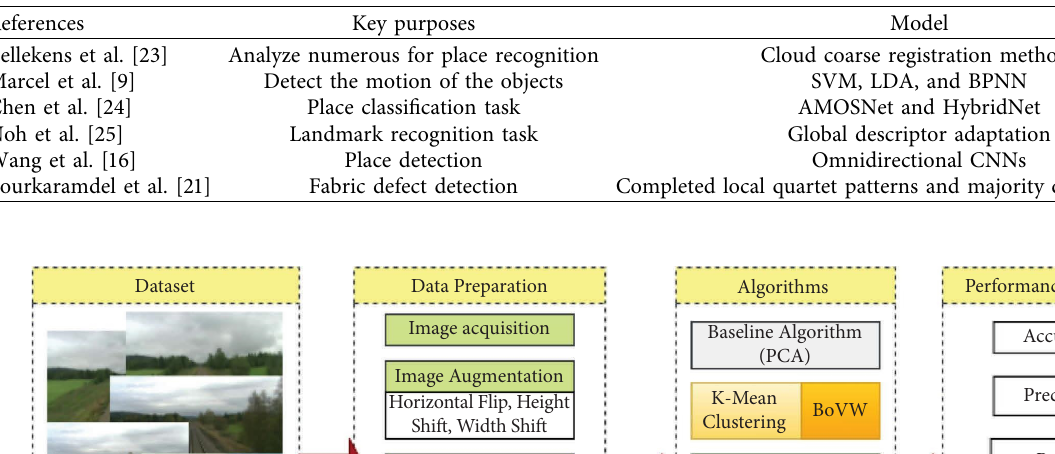
Table 1: Related work of EEG channel prediction using various techniques.